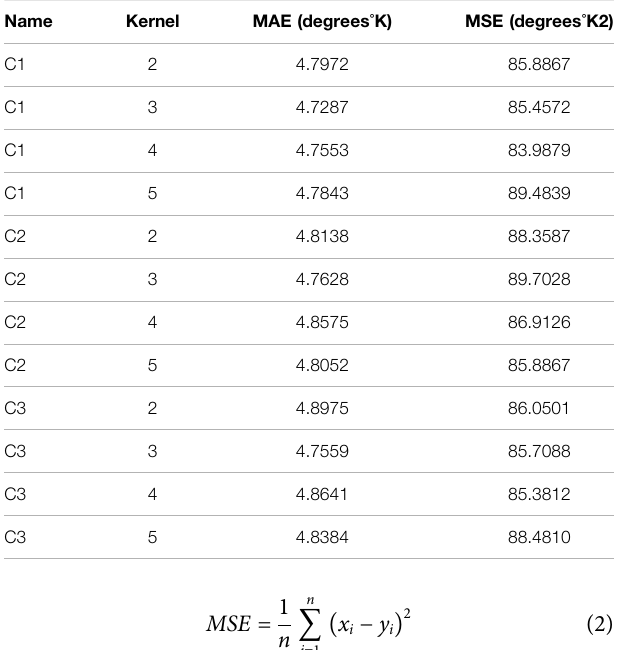
TABLE 2 | Results of training of convolutional neural networks with different kernels.